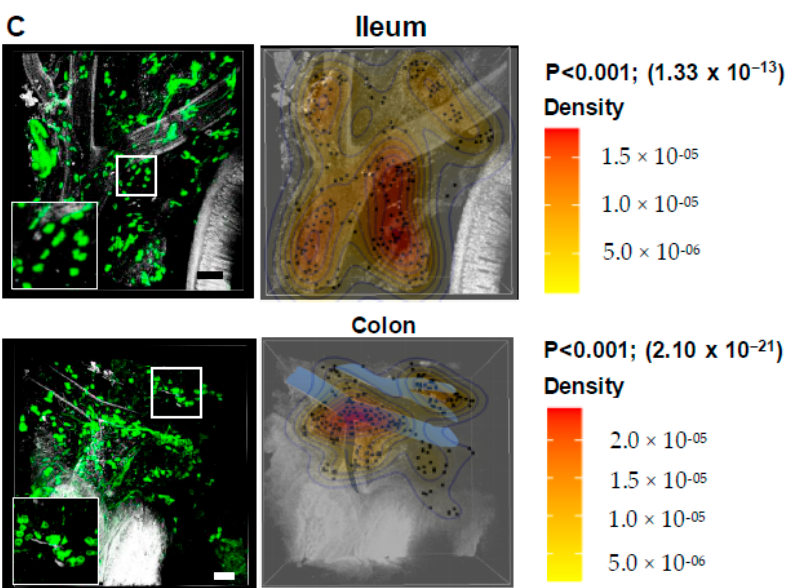
Figure 4. Type-1 adipocytes are spatially distributed in adipose tissues around the ileum and colon in Wt1-cre ERT2 /ROSA26 mTmG mice. ( A ) Type-1 adipocytes are observed in greater number in adipose tissues associated with ileum and colon. ( B ) Quantitative analysis of percentage of occupied volume of Type-1 GFP+ adipocytes to the overall fat volume per frame. Data are shown as mean ± SEM of two ~6-week-old mice, four frames/mouse. ( C ) Representative images of mesenteric fat around the ileum and colon, and Kernel density estimation (KDE) demonstrate the non-random clustering distribution of Type-1 adipocytes in these regions. KDE estimate the probability of finding Type-1 cells is higher in red areas and lower in yellow areas. Blue vessels are a digitized depiction of vessels based on the autofluorescence from the tissues. All pictures were taken at 100x magnification. Scale bar = 100 µ m. In all images, green indicates Alexa 647 to detect anti-GFP signals, while the gray represents tissue autofluorescence. p < 0.05; two-way ANOVA; * <0.05.